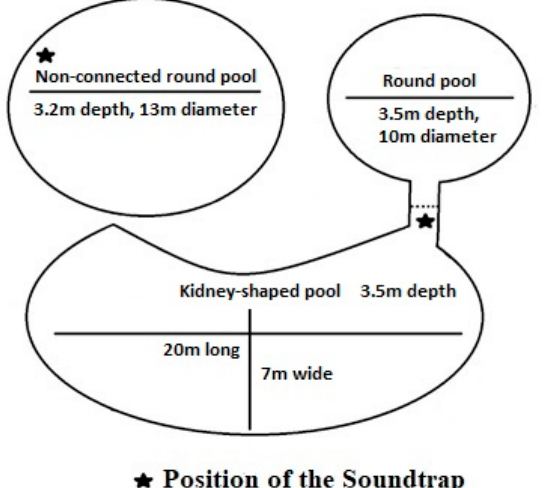
Figure 1. Design of the housing pools and position of the Soundtrap in both pools.